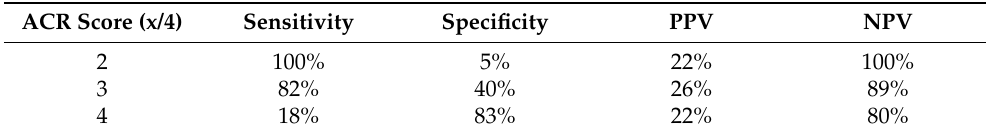
Table 6. Performance scores for ACR (pre-test) and TAB.